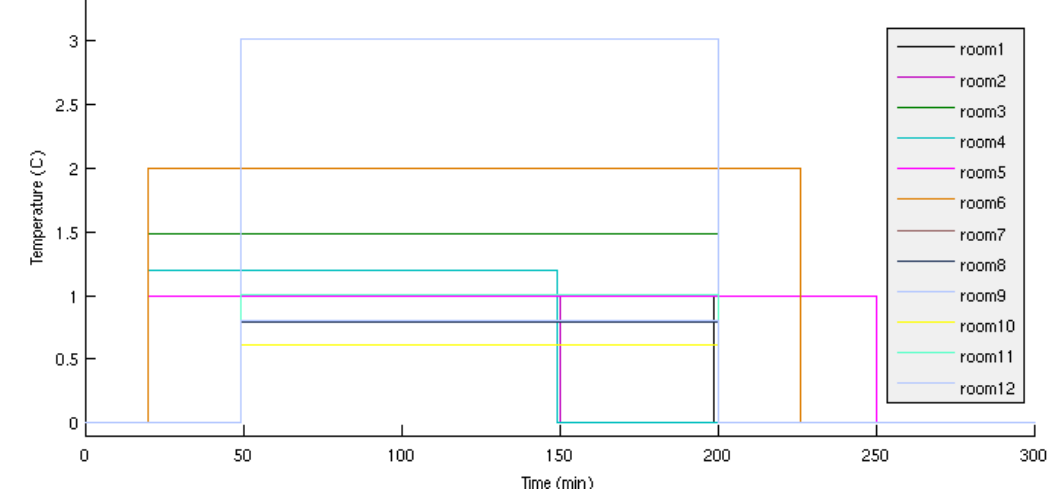
Figure 8. The plot shows different disturbance additive and constant in every room, which can be caused by people entering the room, electronic equipment necessary for operations on patients, external influences,